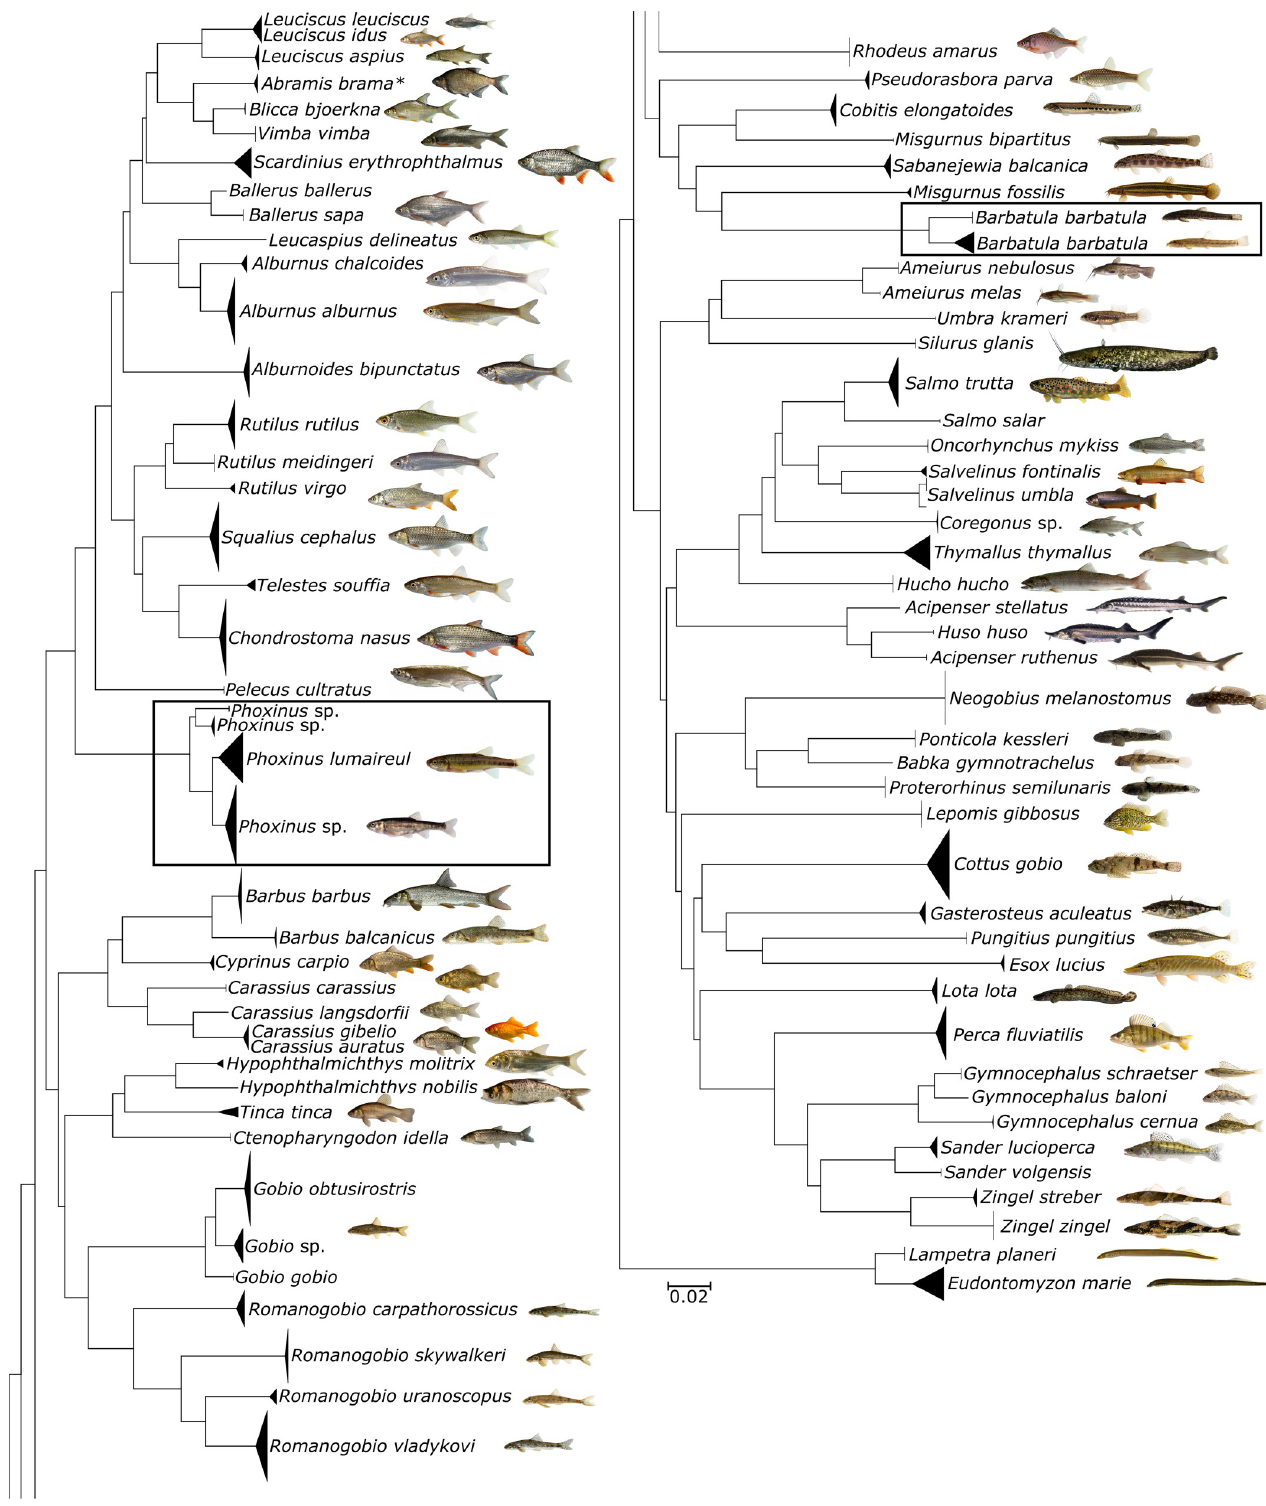
Fig 2. NJ tree based on DNA barcode sequences of Austrian fish species. NJ tree of Austrian teleost fish and lamprey species based on K2P distances of 1,016 COI DNA barcode sequences. The topology of the tree was inferred with the “Taxon ID Tree” tool implemented in BOLD and visualized in FigTree v1.4.4 (http://tree.bio.ed.ac.uk/software/figtree/). Black frames mark species that are investigated in a broader geographic context further below.